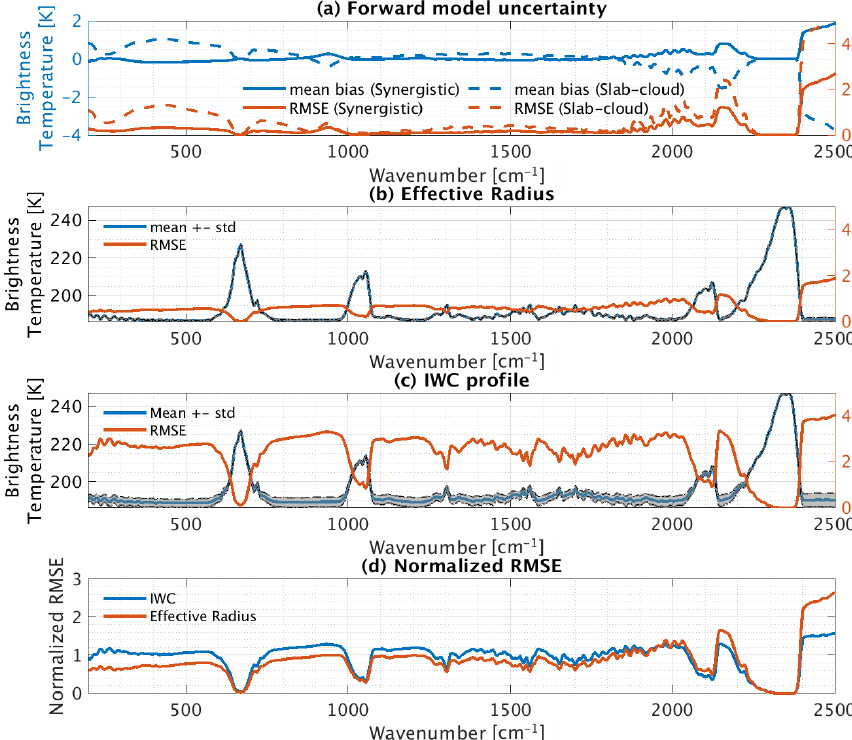
Figure 3. Effects of variations in tropical deep convective clouds on infrared radiance spectra from 200 to 2500cm − 1 at 5cm − 1 resolution. (a) The mean bias (blue, left y axis) and RMSE (red, right y axis) in R sc (R e , opt , IWC ) (solid) and R sc (R e , opt , slab ) (dashed), respectively, relative to R mix (R e , IWC ) . (b) The mean radiance spectrum of R sc (R e , opt , IWC 0 ) (blue, left y axis) and its SD (gray area). Red curves (right y axis) show the RMSE in R sc (R e , 0 , IWC ) relative to R sc (R e , opt , IWC ) . (c) The mean radiance spectrum of R sc (R e , 0 , IWC ) (blue, left y axis) and its SD (gray area). Red curves (right y axis) show the RMSE in R sc (R e , opt , IWC 0 ) relative to R sc (R e , opt , IWC ) . (d) The RMSE in R sc (R e , 0 , IWC ) relative to R sc (R e , opt , IWC ) (blue) and the RMSE in R sc (R e , opt , IWC 0 ) relative to R sc (R e , opt , IWC ) (red); both are also normalized to the spectral